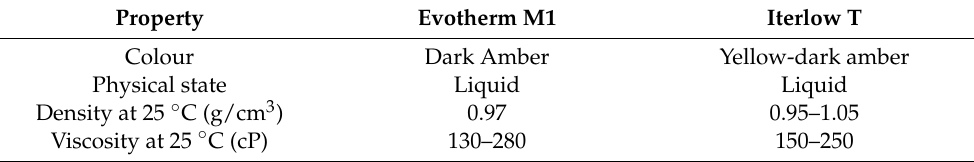
Table 2. Physical properties of the chemical-based additives used in this study.